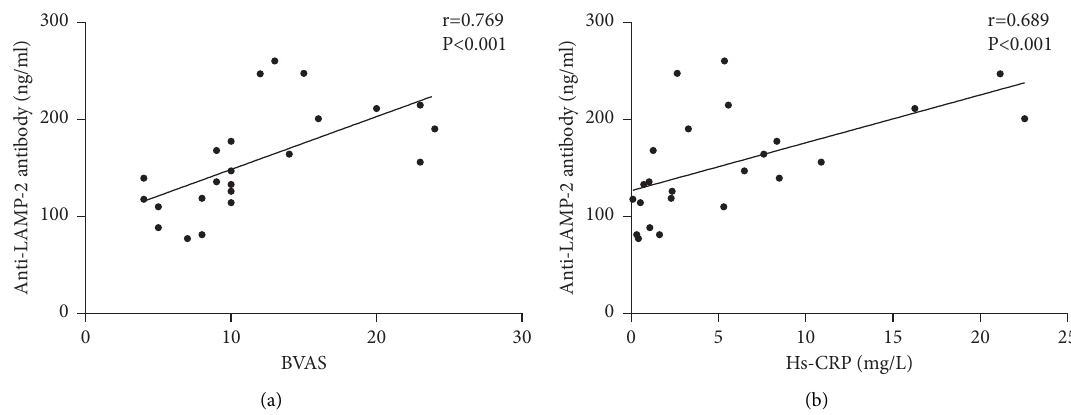
Figure 5: Correlations of anti-LAMP-2 antibody levels with BVAS and Hs-CRP in patients with polyarteritis